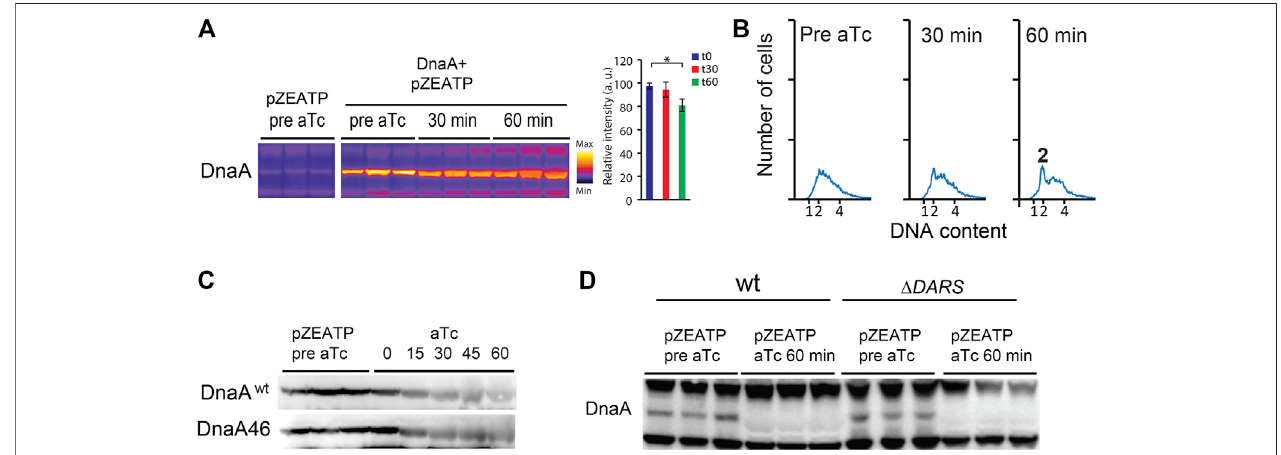
FIGURE 2| DnaA stability isnot signi fi cantly affected by nucleotide binding. (A) The DnaA protein level prior to and following addition of aTc in MG1655Z1/pZATP and MG1655Z1/pZATP+pFH871tooverproduceDnaA(DnaA+).Cellsweregrownunderthesameconditionsasin Figure1 .Proteinsampleswerecorrectedfortotal proteinconcentration.ThehistogramshowsDnaAsignalintensity ± SD(n (cid:2) 3),* (cid:2) p < 0.05. (B) Flowcytometry analysisshowingtheDNAcontentofMG1655Z1/pZATP + pFH871 (DnaA + ) cells taken prior to and following addition of aTc. (C) The DnaA protein level prior to and following addition of aTc in MG1655 Z1/pZATP and MG1655 Z1 dnaA46 /pZATP grown at 32 ° C in minimal medium supplemented with 0.2% glucose. Protein samples were corrected for total protein concentration. (D) The DnaA protein level prior to and following addition of aTc in MG1655 Z1/pZATP and MG1655 Z1 Δ DARS1 Δ DARS2 /pZATP grown in lysogeny broth (LB). Note that less proteins were loaded in the last three lanes as seen by weaker upper and lower cross-reacting